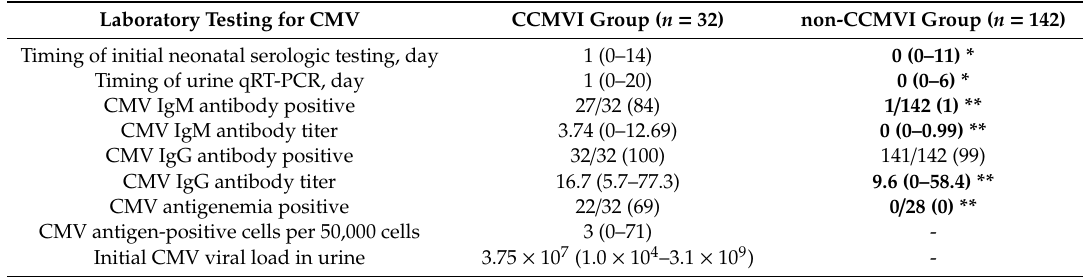
Table 2. Results for CMV-specific antibody titer, CMV antigenemia, and initial CMV viral load in urine by PCR in congenitally infected and uninfected